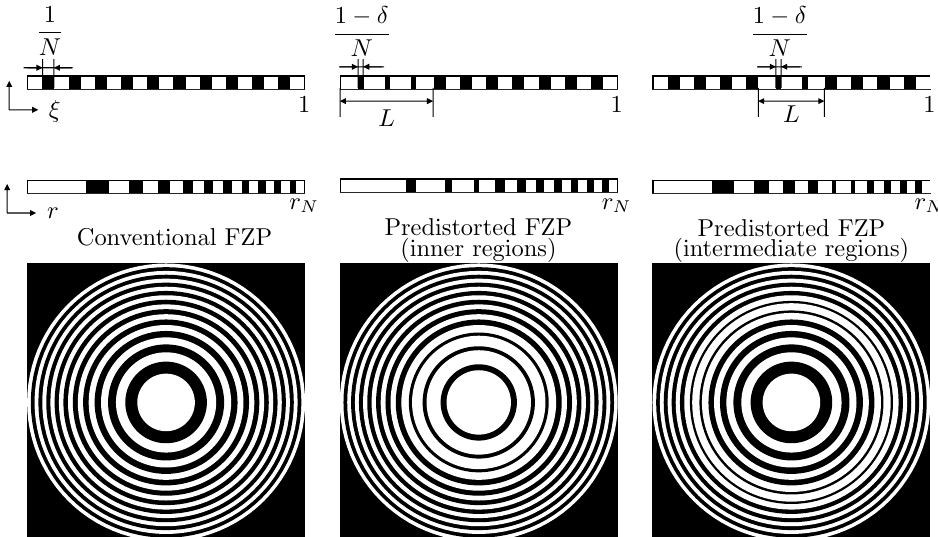
Figure 2. Schematic view of a conventional FZP ( left ), a predistorted FZP with L = 7 inner regions ( center ) and a predistorted FZP with L = 7 intermediate regions ( right ). Top row represents the different Fresnel radii in the normalized ξ domain, second row shows the Fresnel radii along the r -axis, and bottom row represents the corresponding FZP